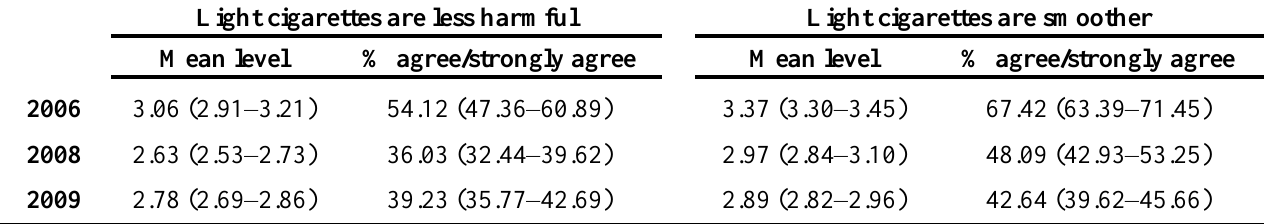
Table 1. Crude mean level of agreement (95% CI) and percentage agree or strongly agree (95% CI) with ―light cigarettes are less harmful‖ and ―light cigarettes are smoother‖ by survey